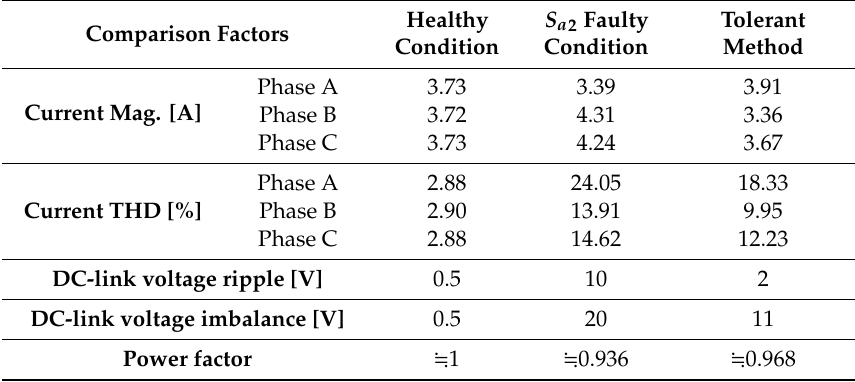
Table 5. Comparison with numerical result under three conditions.